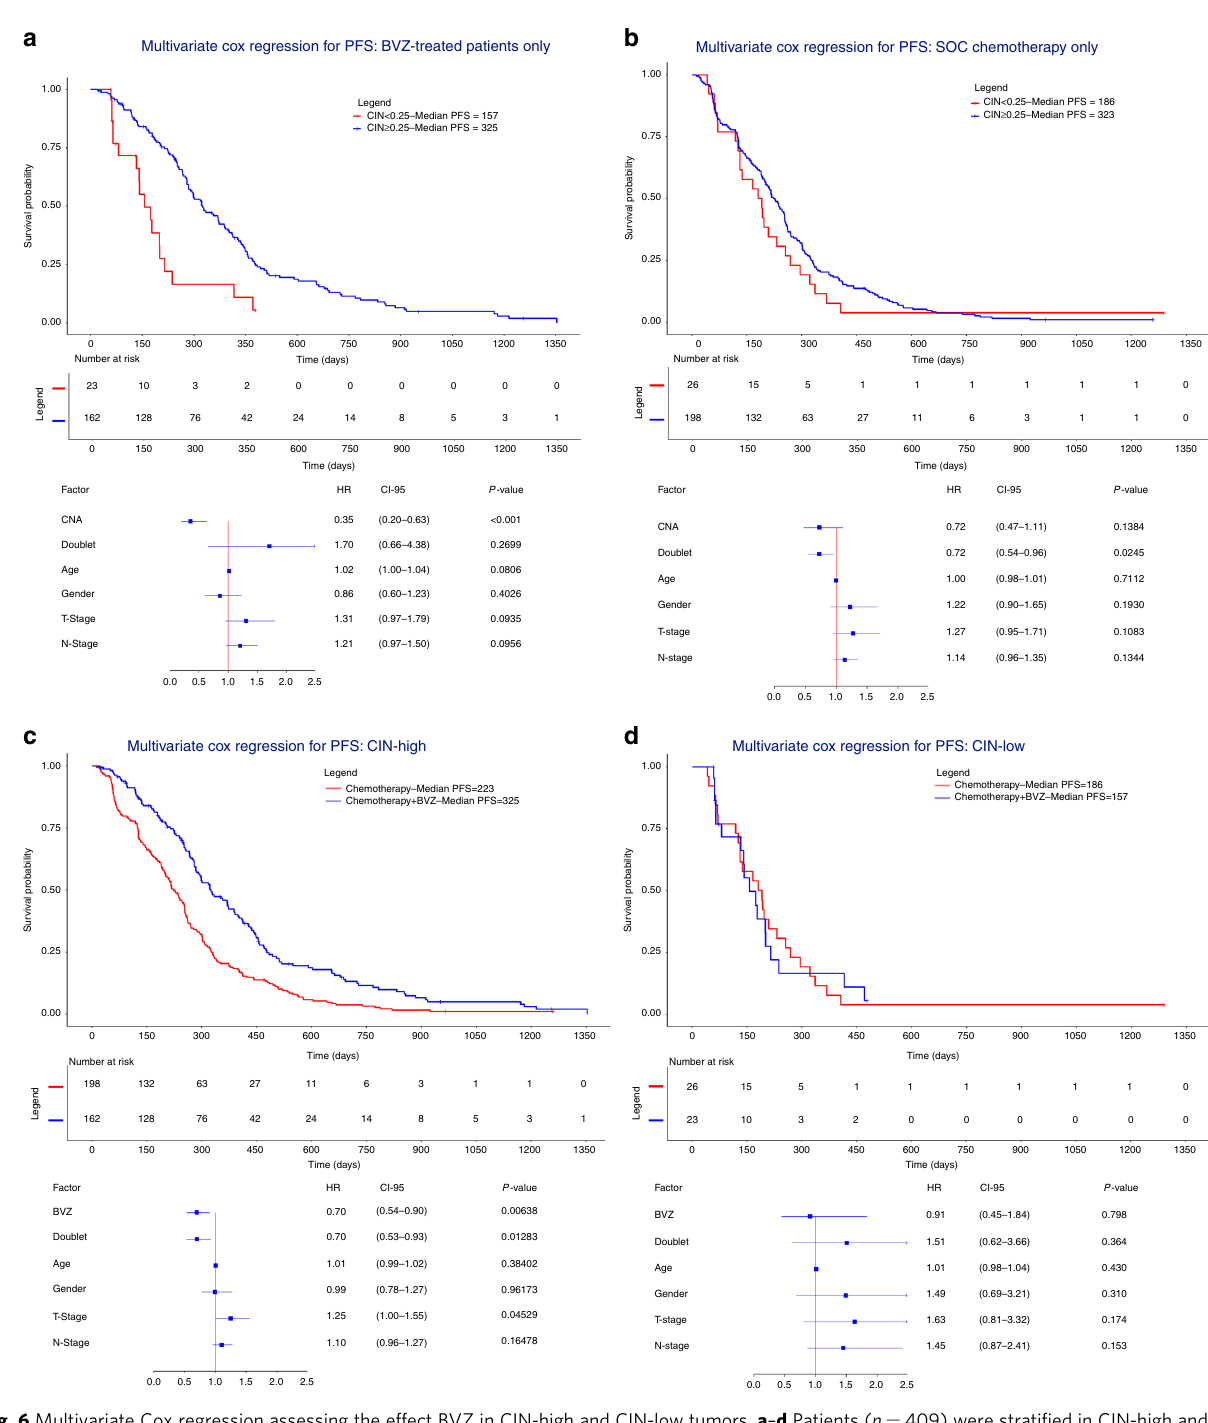
Fig. 6 Multivariate Cox regression assessing the effect BVZ in CIN-high and CIN-low tumors. a – d Patients ( n = 409) were strati fi ed in CIN-high and CIN- low tumors based on CNAs. CIN-high tumors are de fi ned as having ≥ 25% of the chromosomal regions affected by CNAs. Kaplan-Meier and multivariate Cox regression with hazard ratios, 95% con fi dence intervals and P -values for PFS are shown while correcting for the relevant covariates for a patients treated with BVZ having high CIN versus low CIN, b patients treated with standard-of-care chemotherapy having high CIN versus low CIN, c patients with high CIN comparing chemotherapy + BVZ versus chemotherapy alone, and d patients with low CIN comparing chemotherapy + BVZ versus chemotherapy